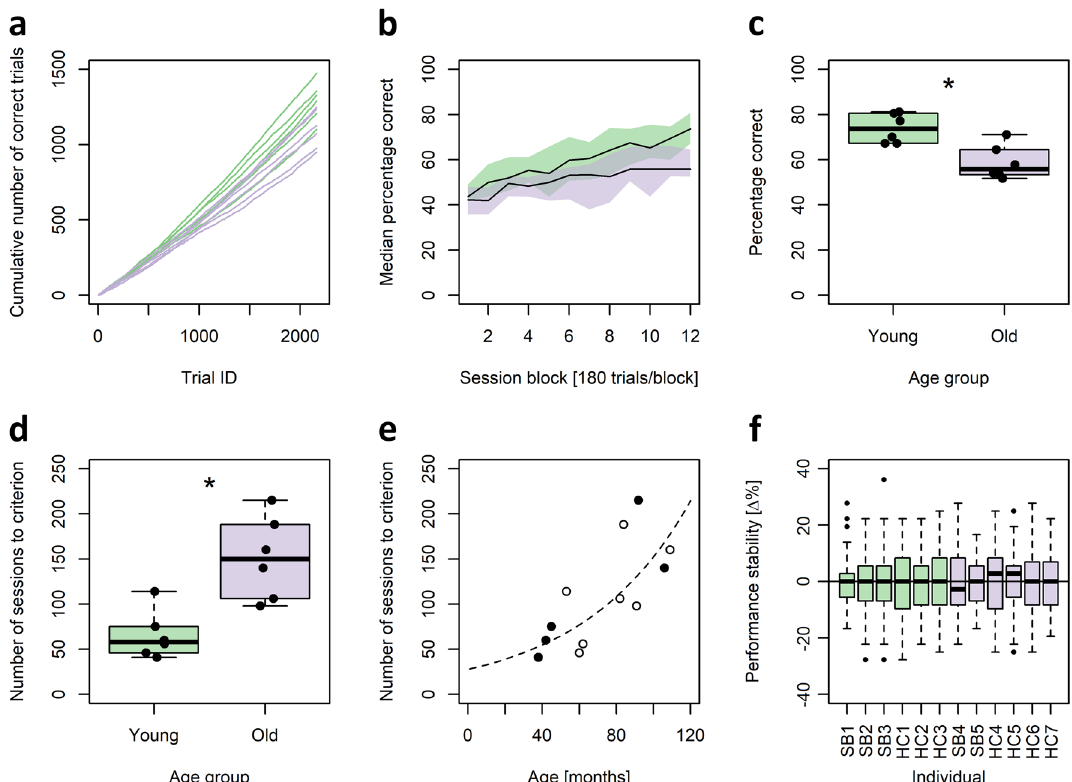
Figure 2. PAL performance and age. ( a ) Cumulative sums of correct responses for young (green) and old (purple) individuals over the first 2160 trials (60 sessions). ( b ) Median learning curves for young and old individuals. Shaded green (young) and purple (old) areas represent the 95% empirical bootstrap confidence intervals of the respective medians. ( c , d ) Group-level comparisons of the individual percentages of correct decisions at session block 12 ( c ) and the number of sessions needed to reach learning criterion C 1 ( d ). Significance code: * p < 0.025; exact Wilcoxon rank sum tests. ( e ) Number of sessions to C 1 as a function of age in months. Filled circles represent individuals trained in a session-based protocol (SB 1 –SB 5 ), hollow circles represent individuals trained in a home cage-based protocol (HC 1 –HC 7 ). The dashed line represents